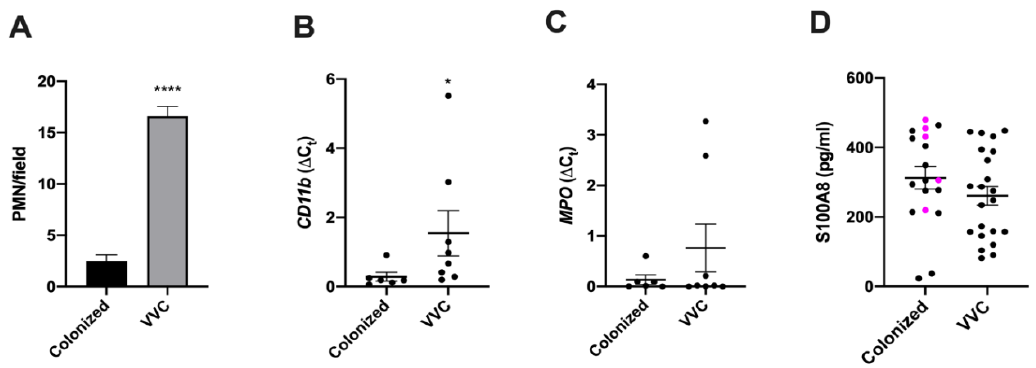
Figure 1. PMN number, CD11b and MPO gene expression and S100A8 determination. ( A ) Mean ± SEM of PMN number / field from vulvovaginal candidiasis (VVC) or colonized women. ( B , C ) Mean ± SEM of the relative expression of CD11b ( B ) and MPO ( C ) genes from cDNA obtained from cellular pellets of VVC and colonized women (data were obtained from the analysis of samples indicated in Table S1). ( D ) S100A8 was assessed in vaginal fluids (VF) of VVC and colonized women. The samples from women colonized by non- albicans Candida (NAC) species are colored in magenta. Level of significance is indicated by **** p < 0.0001 and by * p = 0.0127. Table 1. Summary of the data (mean ± SEM) on anti- Saccharomyces cerevisiae antibodies (ASCA), anti-